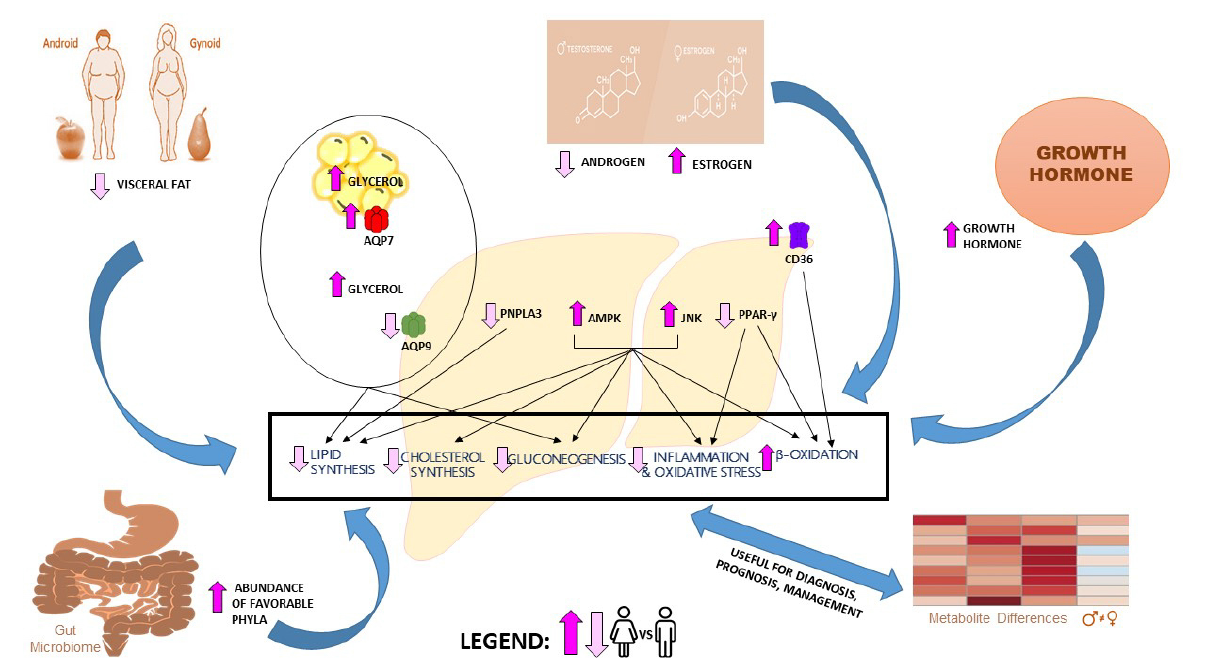
Figure 1. Sex differences in NAFLD pathogenesis. Compared to men, women exhibit higher plasma glycerol due to their higher lipolytic rate and abundance of AQP7 in visceral adipose tissue. Women also exhibit lower hepatic AQP9 expression and lower glycerol permeability than men. These differences in glycerol levels and AQP expression lead to a lower prevalence of NAFLD and insulin resistance in women. Lower CD36 expression in women is associated with increased β-oxidation. Increased JNK and AMPK in women are associated with decreased DNL, decreased cholesterol synthesis, decreased gluconeogenesis, decreased inflammation, and increased β-oxidation. Decreased PPARγ expression in women is associated with decreased inflammation and increased β-oxidation. Decreased PNPLA3 expression in women is associated with decreased accumulation of lipid droplets. Increased GH and estrogen levels in women are known to have a protective role in NAFLD development. The presence of favorable bacterial phyla in the female gut is associated with less steatosis development and less hepatic inflammation. In silico analysis showed several metabolites showing sex-associated differences in NAFLD patients that could be potential biomarkers and therapeutic targets. The conditions showing upregulation (bright pink) or downregulation (light pink) in women compared to men are